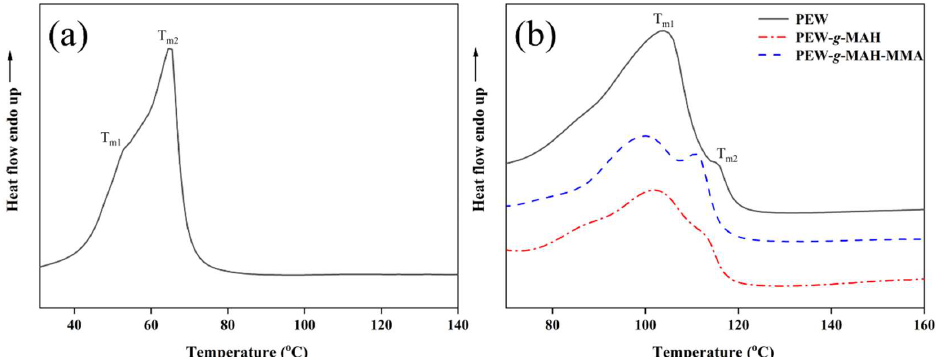
Figure 7. DSC secondary heating curves of ( a ) BW ( b ) PEW, PEW- g -MAH, and PEW- g